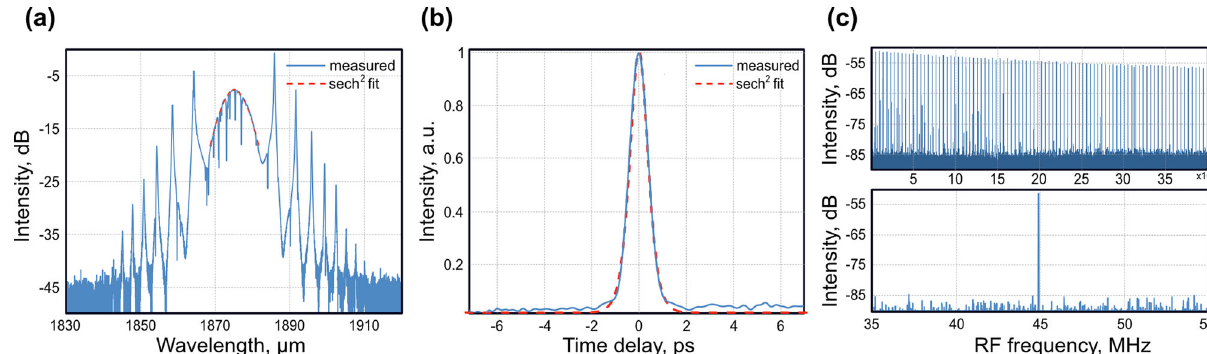
Fig. 6 Measured output pulse characteristics with highest average power. a Optical spectrum centred at 1889 nm; b autocorrelation trace with sech 2 fi t; c RF spectrum over 40 GHz (i) and a close-up of the fundamental frequency